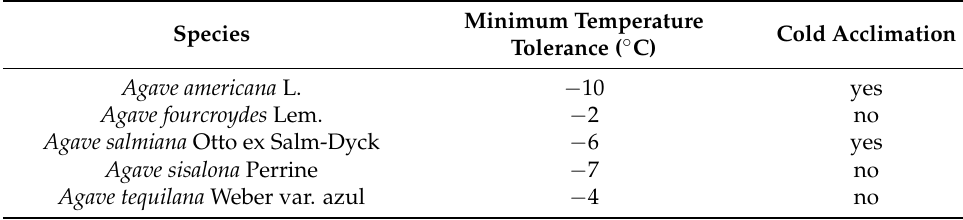
Table 1. Low temperature tolerance of Agave americana and other high-yielding Agave species in agricultural production (sources: [18–22]). Minimum Temperature Species Cold Acclimation Tolerance ( ◦ C) Agave americana L. − 10 yes Agave fourcroydes Lem. − 2 no Agave salmiana Otto ex Salm-Dyck − 6 yes Agave sisalona Perrine − 7 no Agave tequilana Weber var. azul − 4